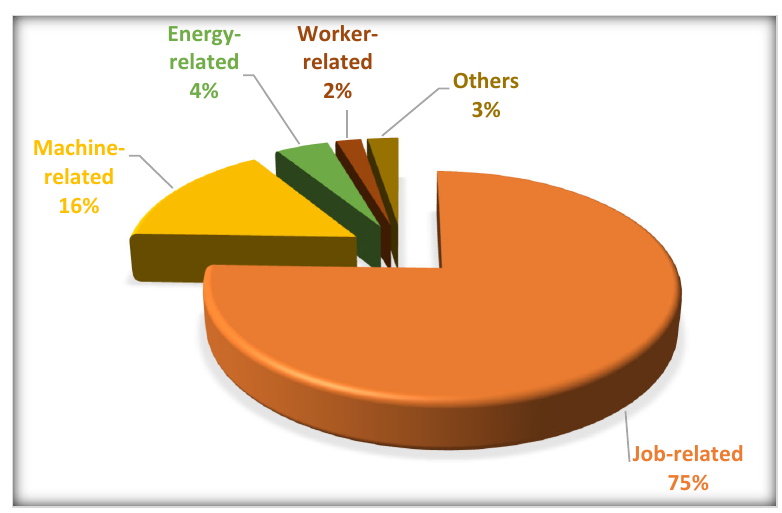
Fig. 9. Numerical analysis of constraints utilized in HFS articles